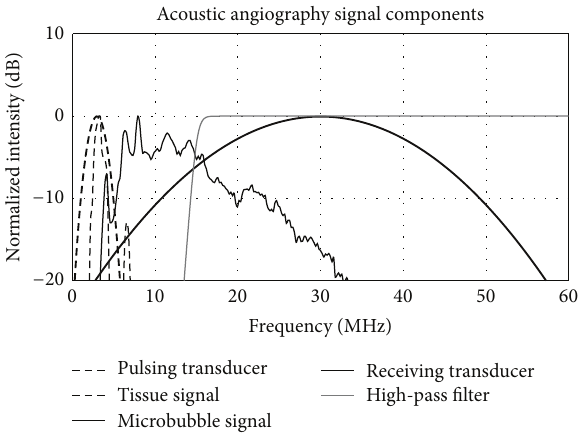
Figure 3: A frequency domain representation of the signals of all transmit and receive components of acoustic angiography imaging. The tissue and bubble responses were acquired using an exper- imental system described previously [17] and are displayed here to illustrate the relationship between the bandwidths and the two transducer elements as well as the tissue and bubble responses, for example, acoustic angiography imaging